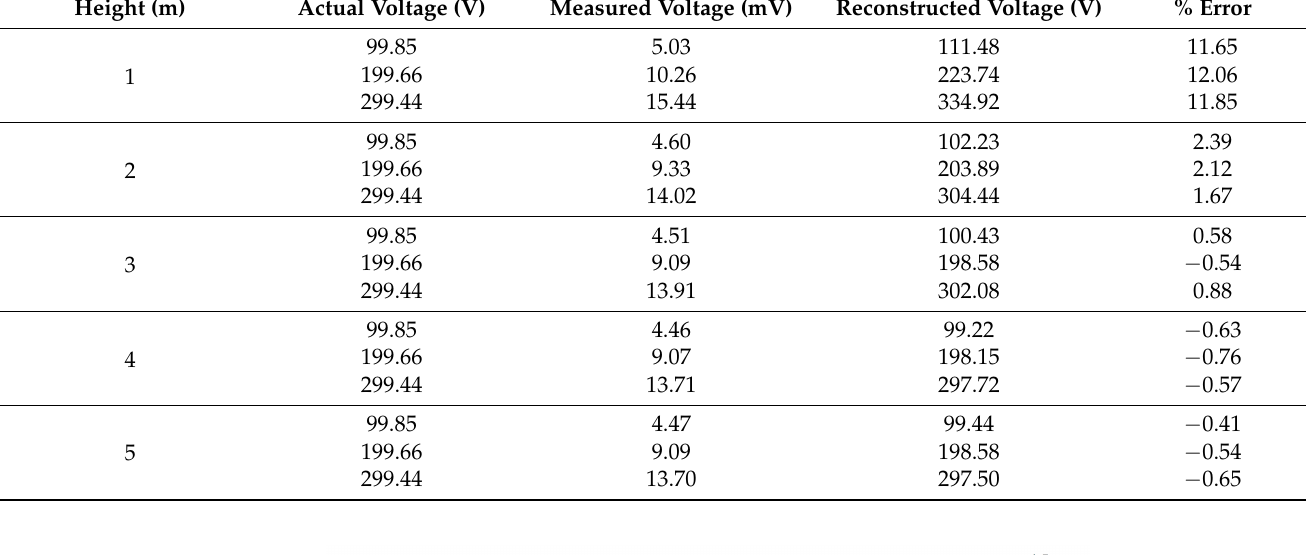
Table 8. Error characteristics of actual output voltage and reconstructed voltage at different heights.